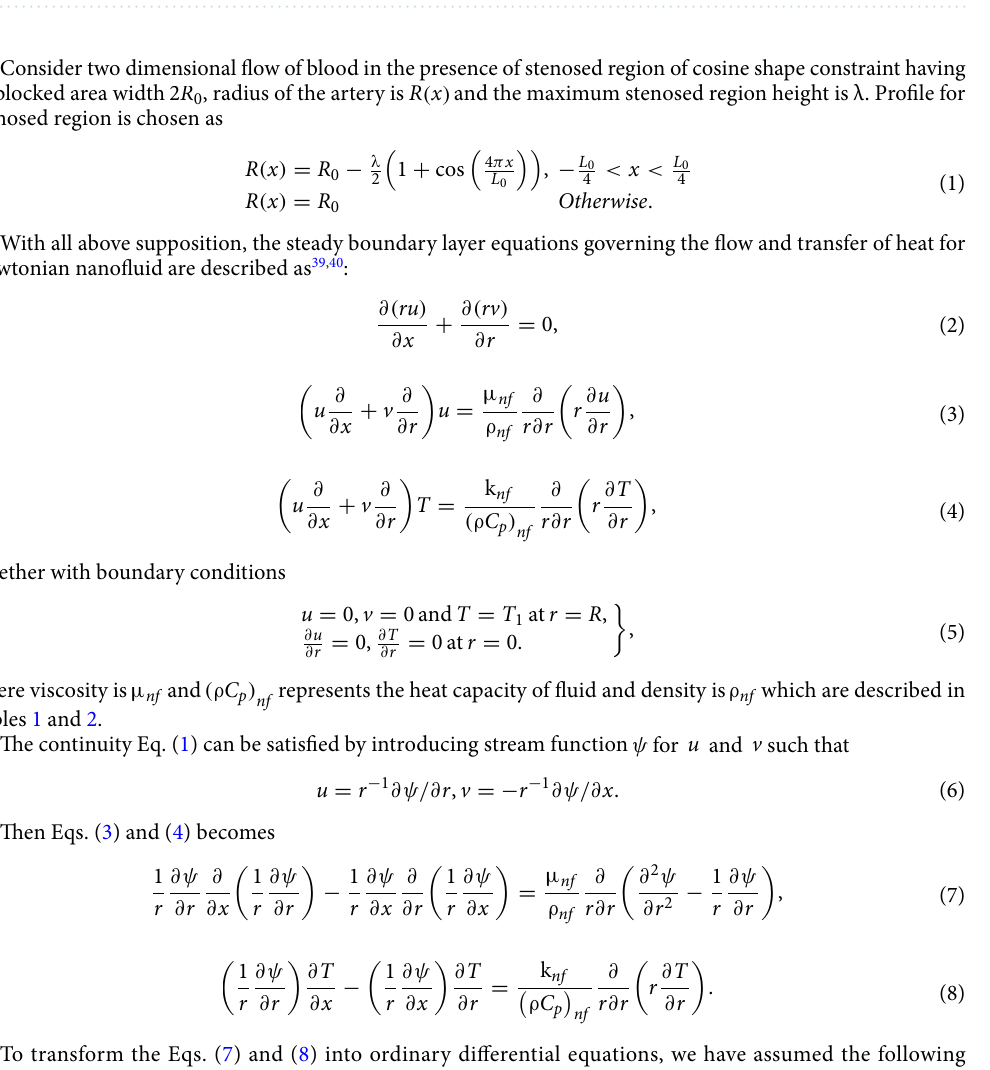
Table 2. Base fluid (blood) and nanoparticles experimental values 42